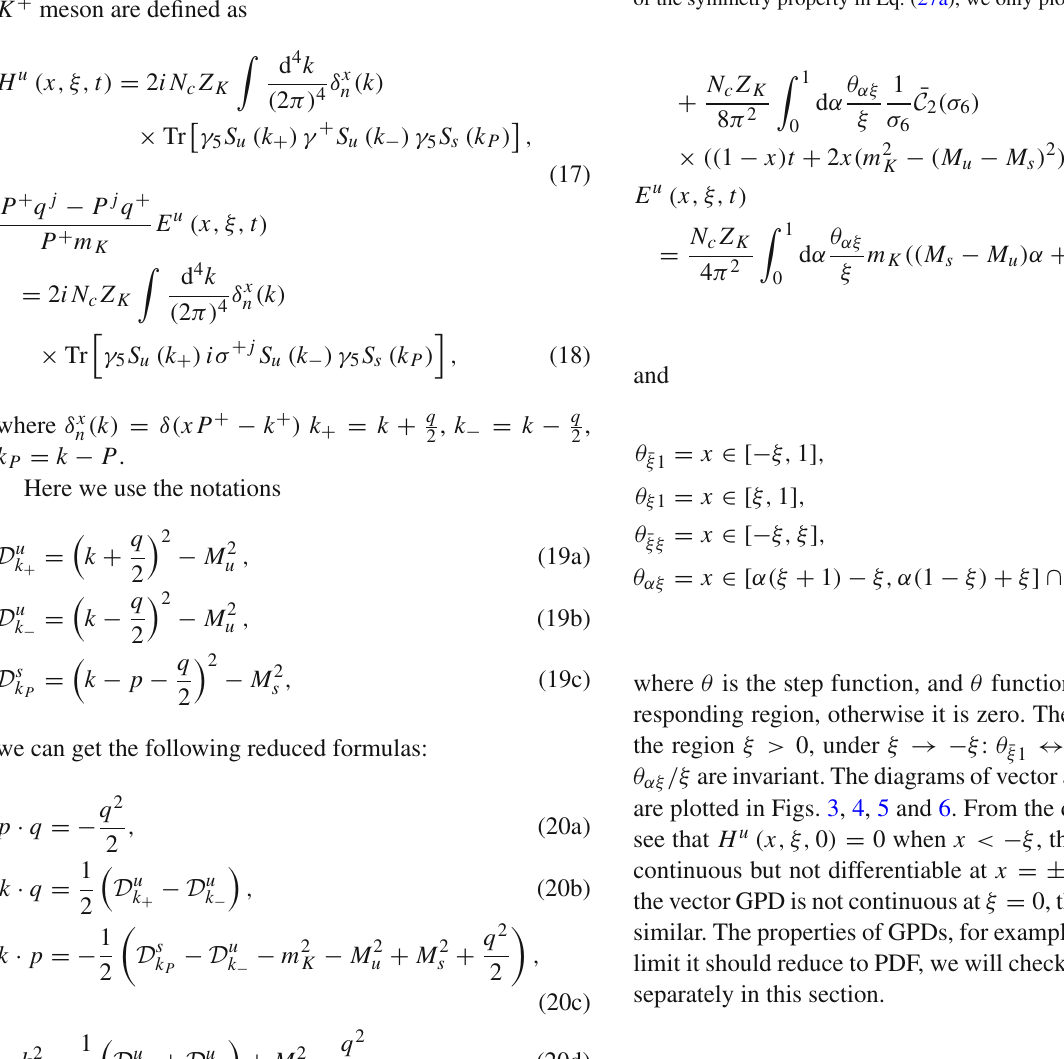
Fig. 3 Kaon vector GPD: left panel – H u ( x ,ξ, 0 ) in Eq. (21), because of the symmetry property in Eq. (27a), we only plot ξ > 0